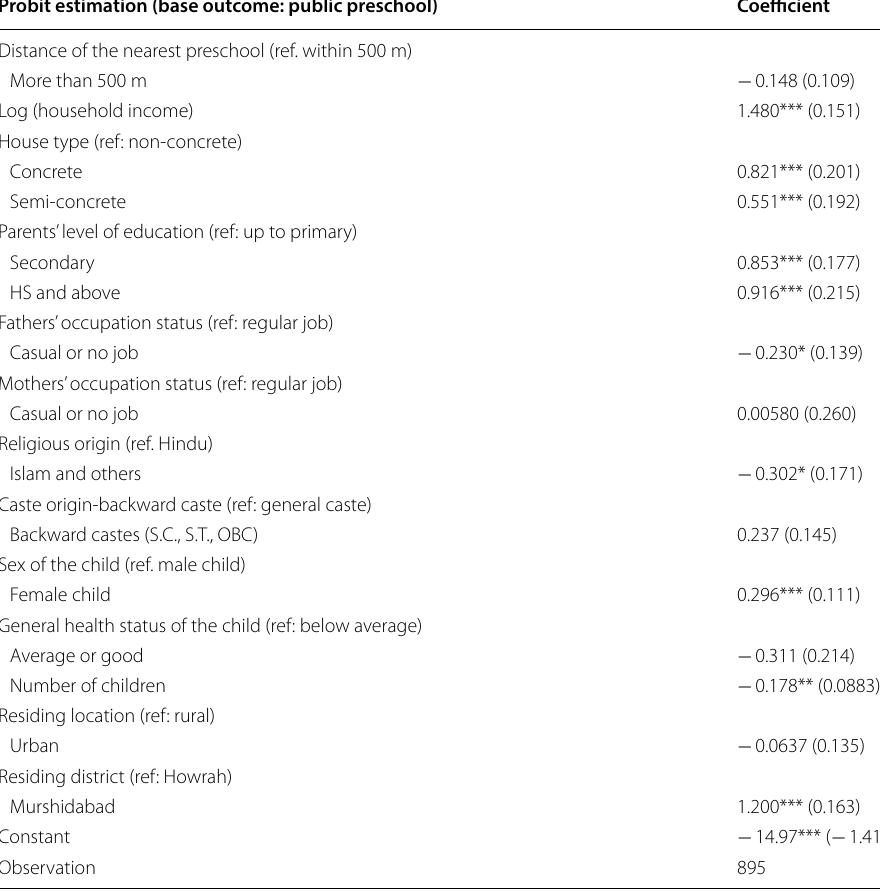
Coefficients represent marginal effects. Standard error in